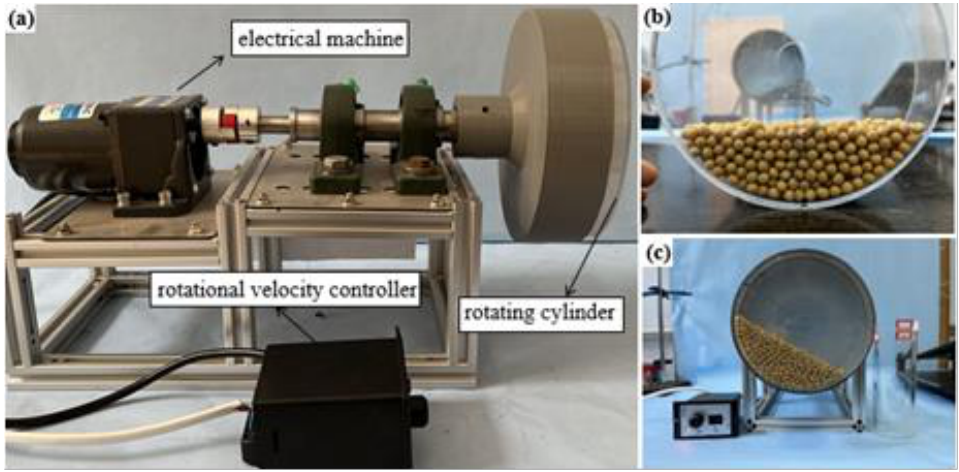
Figure 17. ( a ) The rotating cylinder test apparatus and ( b , c ) the screenshot of test process. After the test device was installed, the power supply was connected, and the speed controller was adjusted to make the drum speed 7.5 rpm. After the speed was stable, the soybean seed particles in the drum formed a dynamic repose angle, such as Figure 17c, recording the dynamic piling process for 30 s. The cylinder speed was adjusted to 11.5 and 15.5 rpm, respectively, and the dynamic stacking process was recorded for 30 s. At the end of the test, the soybean seed particles were weighed for mass. Three replicate tests were conducted for each